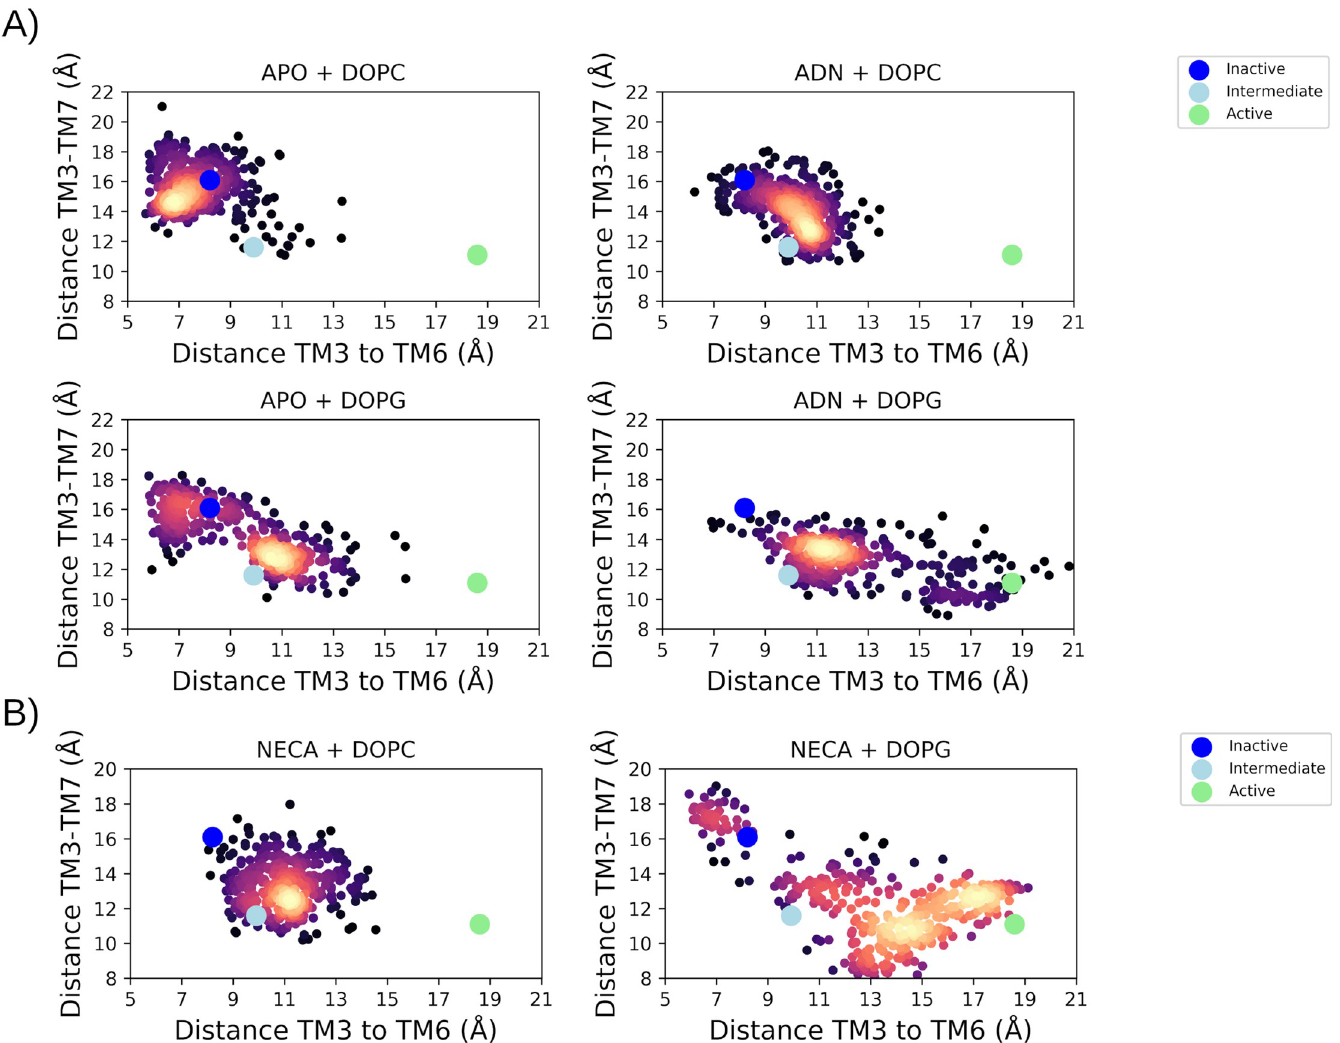
Fig 10. The two-dimensional collective variable (CV) space of A2aR activation and receptor conformations during respective MD simulations: A) apo or with bound adenosine (ADN); B) with bound NECA . CVs correspond to distances between ionic lock residues R3.50 and E6.30 (TM3-TM6), and residues R3.50 and Y7.53 (TM3-TM7). The reference distances from inactive, intermediate and active crystal structures are shown as blue, cyan, and green dots, respectively. Frequency of receptor conformation is represented by a “heat” scale (low: black, high: yellow).